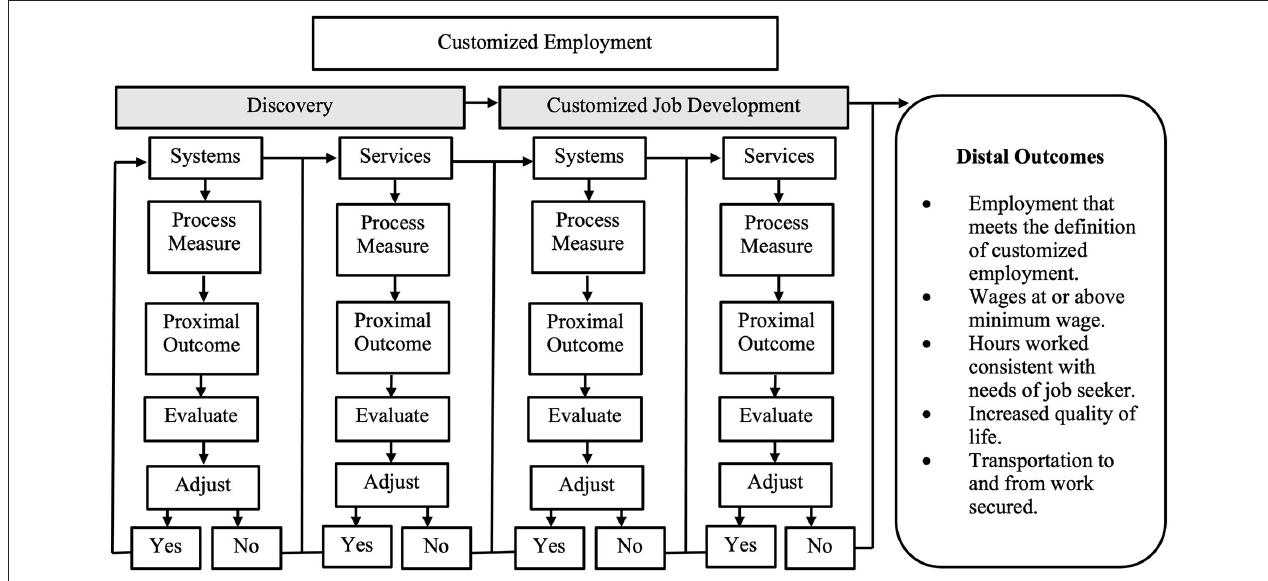
FIGURE 1 | A conceptualization for integrating and linking processes and corresponding proximal and distal outcomes for